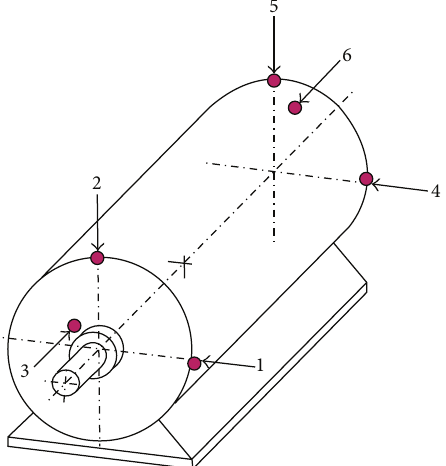
Figure 3: ISO 10816 recommended positions for vibration mea- surements [28], where position-1 and position-4 indicate radial- horizontal directions and position-2 and position-5 indicate radial- vertical directions, while position-3 and position-6 indicate the axial directions. Position-1, position-2, and position-3 locate nearby the loading side, while position-4, position-5, and position-6 locate nearby the nonloading side.